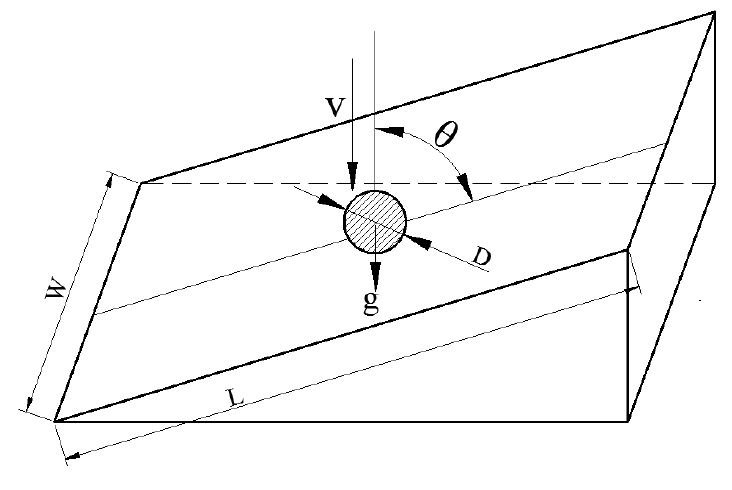
Figure 1. Oil droplet impact with solid wall.